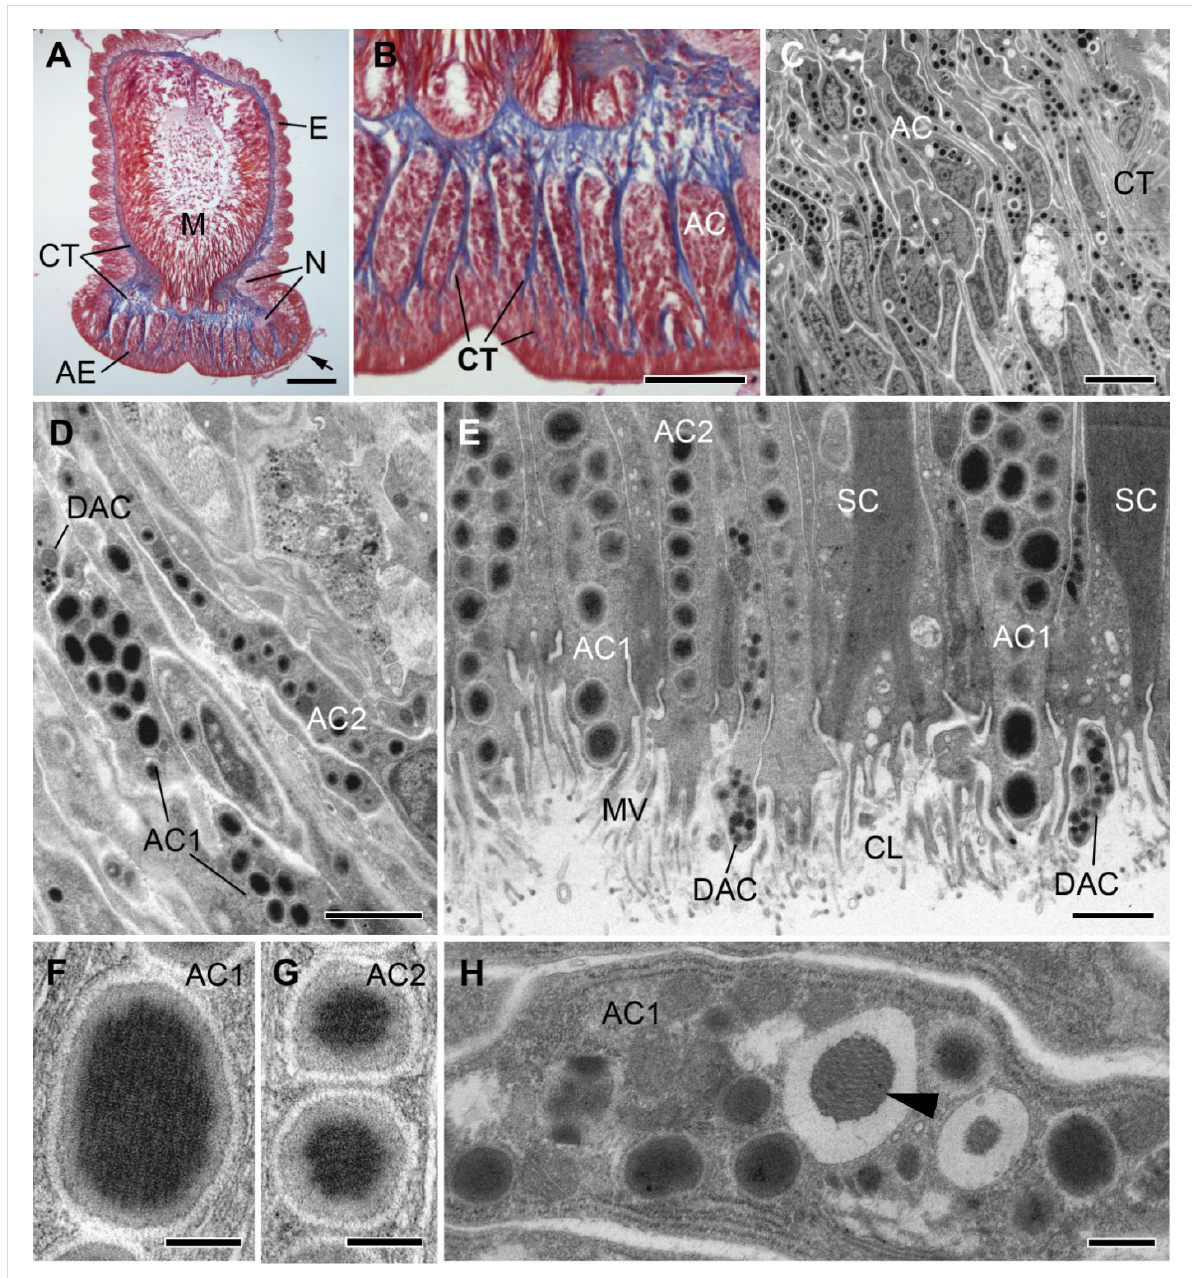
Figure 2: Fine structure of the tube feet of Asterina gibbosa observed in light microscopy (A,B) and TEM (C–H). (A,B) Longitudinal histological section through a tube foot stained with Heidenhain’s azan trichrome. Arrow highlights remains of adhesive material. (C–H) TEM images of longitudinal tube foot sections, arrowhead in (H) indicates inner core of secretory granule. See text for details. AC - adhesive gland cell; AE - adhesive epidermis; CL - cuticular layer; CT - connective tissue; DAC - de-adhesive gland cell; E - epidermis; M - myomesothelium; MV - microvilli; N - nerve strands; SC - supportive cell. Scale bars: (A) 100 µm; (B) 50 µm; (C) 5 µm; (D) 2 µm; (E) 1 µm; (F,G) 0.2 µm; (H) 0.5